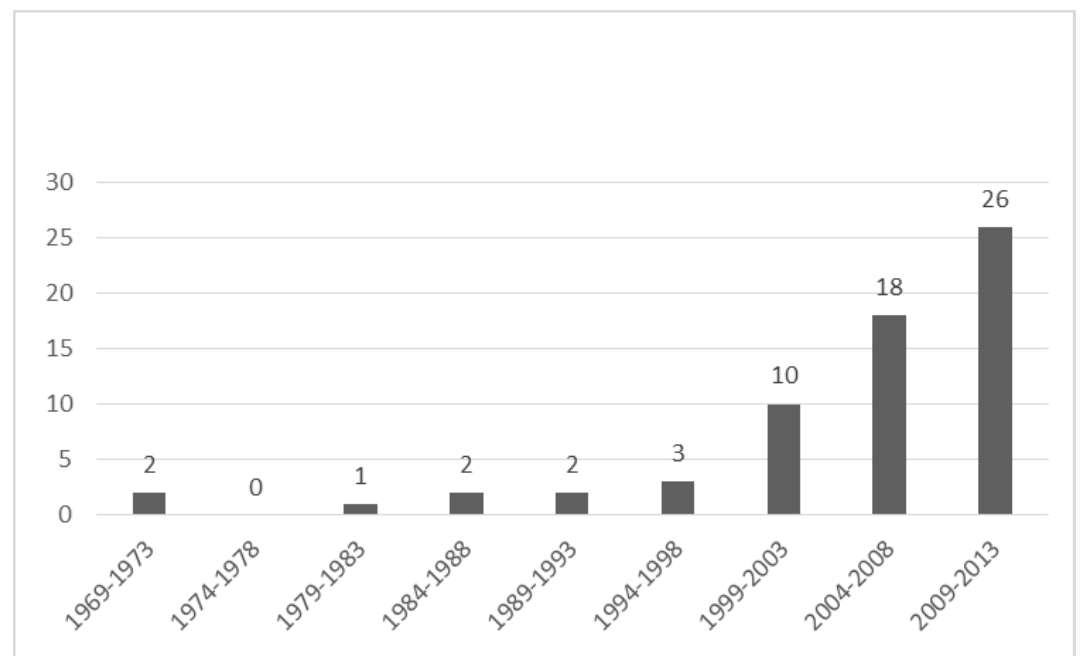
Figure 1. Number of popular films with video surveillance as plot element,